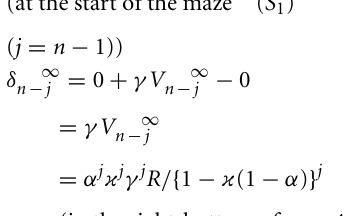
equal value in Figure 2Cd (indicated by the red circle in the left (“Error”) panel of the figure attached to this Corrigendum) because “ R ” was mistakenly dropped (i.e.,